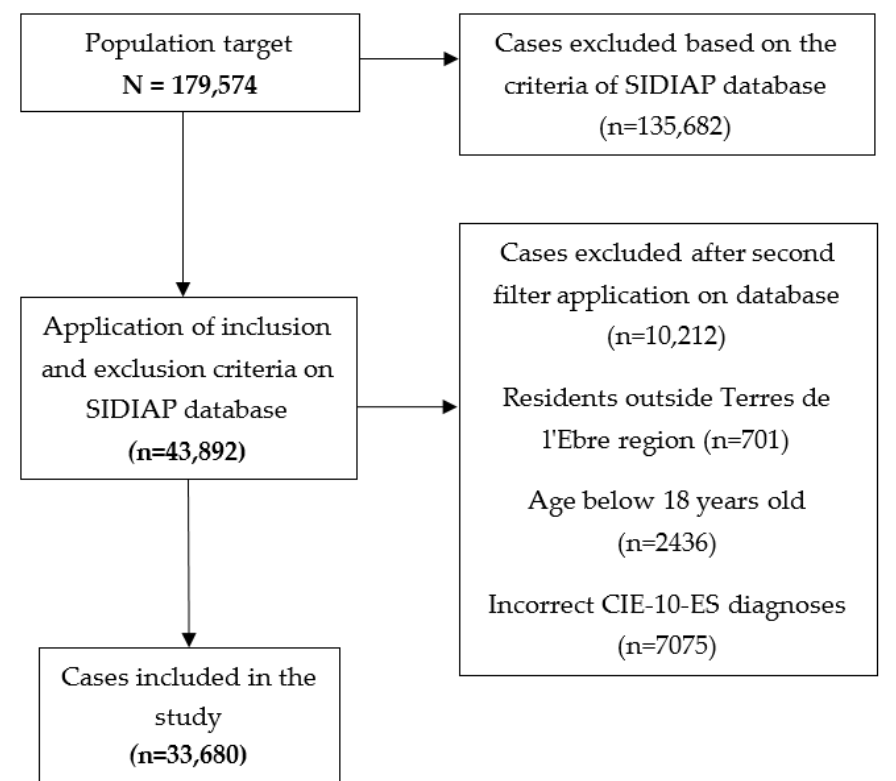
Figure 1. Selection diagram of the cases included in the study.